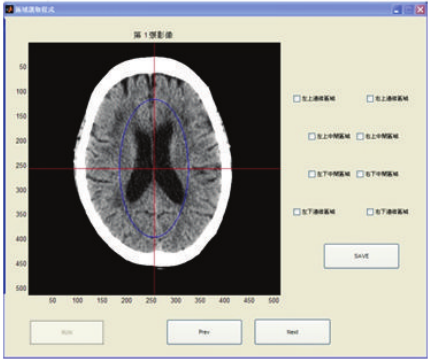
Figure9:Userinterfaceforrecordingradiologists’assessmentbased on the original image (Test 1).